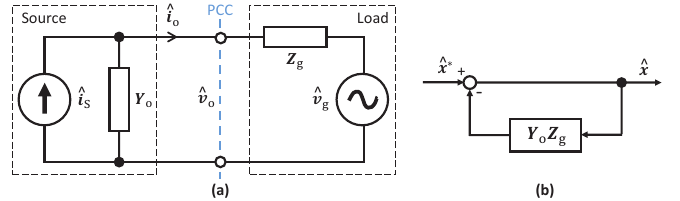
Figure 1. Interconnected source-load subsystem ( a ) and its simplified feedback-system equivalence ( b